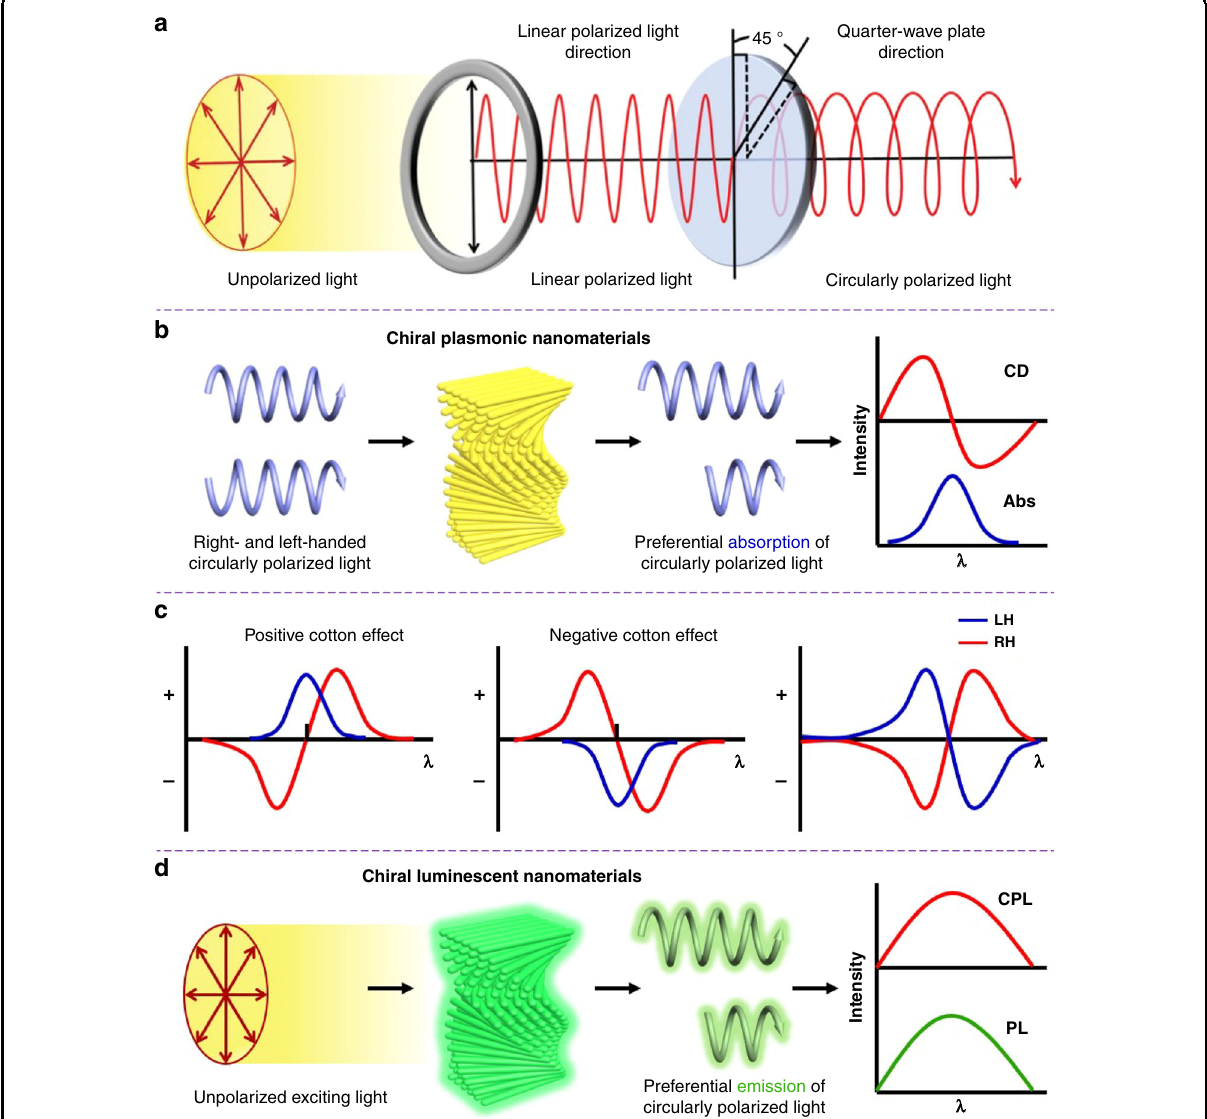
Fig. 2 Chiroptical properties of chiral nanomaterials. a The relationship between unpolarized light, linearly polarized light and circularly polarized light. Reproduced with permission from ref. 111 . Copyright 2020, WILEY-VCH. b Schematic illustration of circular dichroism (CD). c Typically cotton effect (left and middle) and bisignate CD spectra (right) in chiral nanomaterials. d Schematic illustration of circularly polarized luminescence